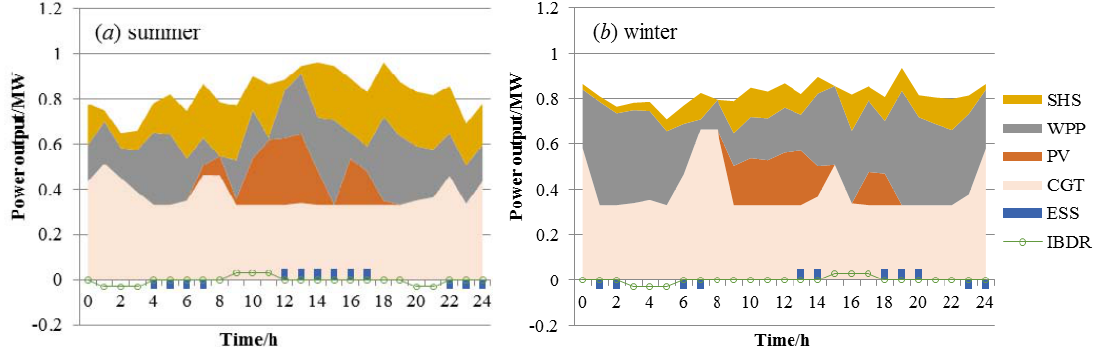
Figure 10. Output distribution of VPP power generation on typical load days in Case 3.